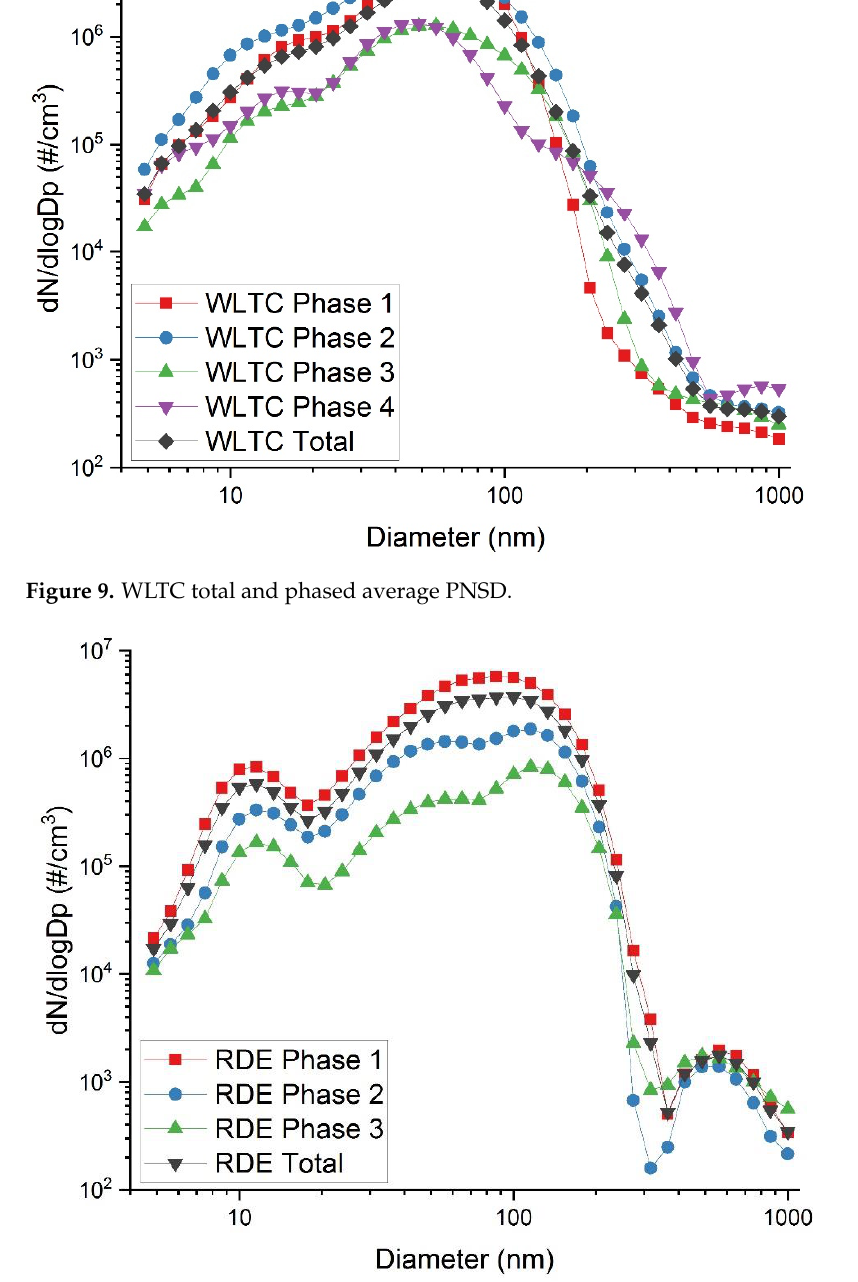
Figure 10. RDE total and phased average PNSD.